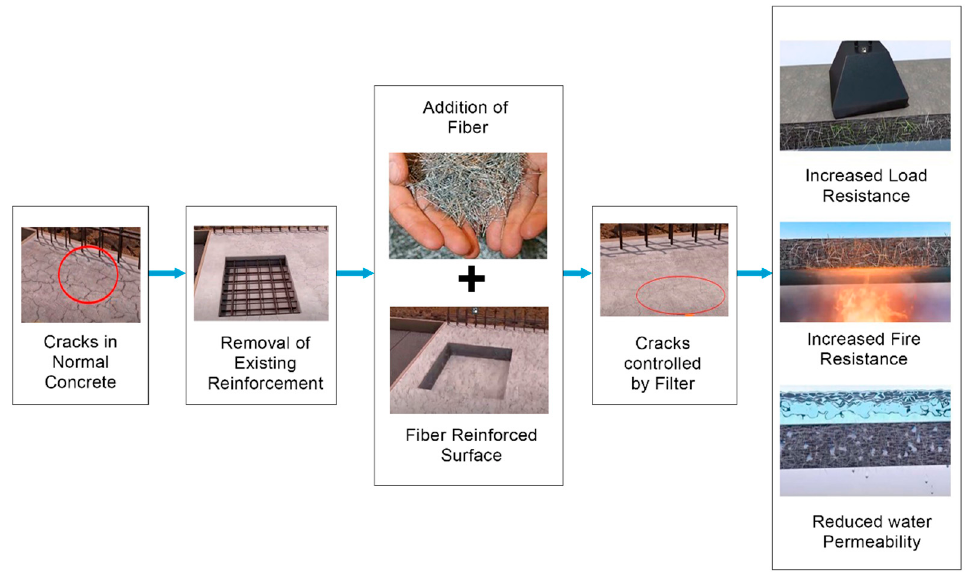
Figure 4. Mechanism for the repair of cracks in SFRC.